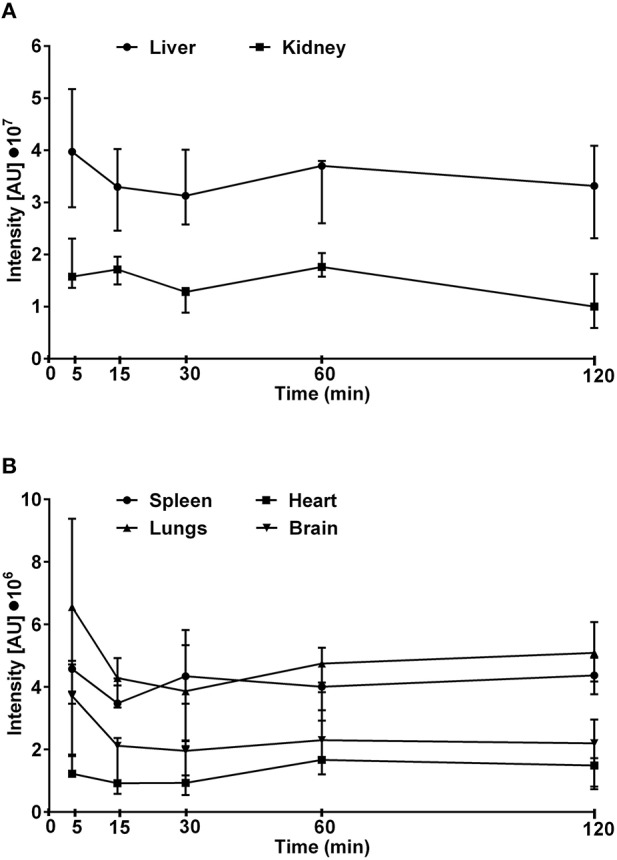
The intensity of fluorescence measured in kidneys and liver (A) or lungs, heart, spleen, and brain (B) isolated from mice treated intravenously with rhodamine-labeled Dex40-GTMAC3 (22.5 mg/kg), 3 min following UFH (300 U/kg) administration. The signal intensity in control group (0.9, 0.9, 1.0, 1.2, and 1.0 I[AU]•107 in livers, 0.2, 0.3, 0.2, 0.2, and 0.2 I[AU]•107 in kidneys, 2.5, 2.8, 2.4, 2.0, and 1.6 I[AU]•106 in lungs, 1.1, 1.5, 1.3, 1.1, and 1.3 I[AU]•106 in spleens, 0.4, 0.7, 0.7, 0.9, and 0.5 I[AU]•106 in hearts, 1.4, 2.8, 2.4, 2.5, and 2.5 I[AU]•106 in brains, for 5, 15, 30, 60, and 120 min, respectively) was subtracted from the presented results. Results are presented as median, upper/lower limits.